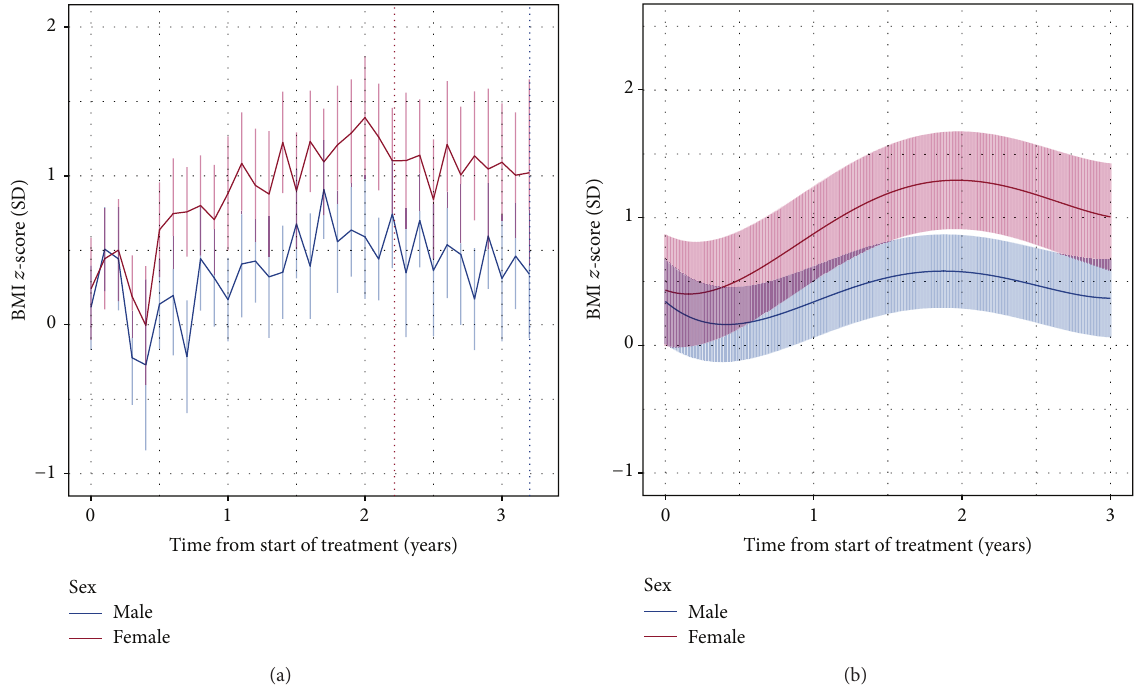
Figure 3: Longitudinal changes in BMI 𝑧 -scores for males and females from the start of treatment for ALL. (a) Raw sex-specific means and 95% confidence intervals. (b) Predicted means for BMI 𝑧 -scores and 95% confidence intervals in the mixed-effects model adjusted for sex. Vertical dotted lines indicate the mean time at the end of treatment for males and